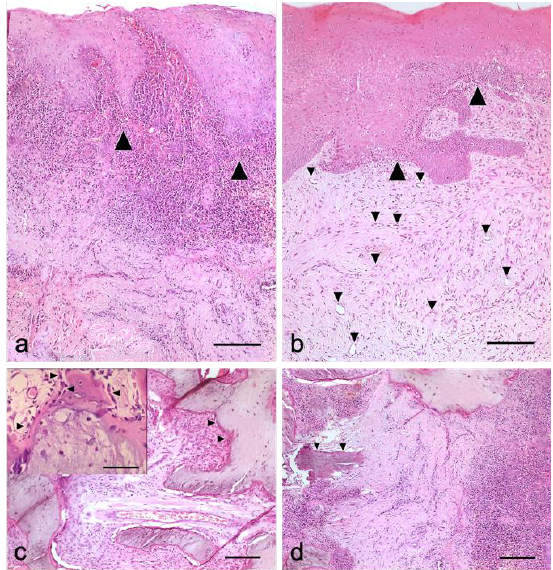
Figure 7. Histological photomicrograph of hematoxylin and eosin (H&E)-stained sections of bioptic samples from a post-extractive surgical wound, three weeks after the surgery: ( a ) untreated sample from control group shows an abundant infiltration of inflammatory cells in the epithelial layer (arrow heads), with an irregular epithelial layer, micro-hemorrhages, and extensive edema, indicating poor repair parameters; ( b ) surgical site treated with PRF reveals scant inflammatory cells with epithelial hyperplasia (big arrow heads) and new collagen synthesis with irregular orientation, which is associated with remarkable neo-angiogenesis (arrow heads); ( c ) biopsy sampled at the level of the periodontal bone from a surgical site treated with PRF evidences ontogenetic processes (arrow head), with some new osteoid-synthetizing basophilic osteoblasts with large activated nuclei (insert, arrow heads); ( d ) bone sampled from a surgical site in which no treatment was applied—a moderate persisting inflammatory response with some fragments of bone being resorbed by osteoclasts is indicated by the arrow head. H&E, scale bar = 400 µm (In insert, bar = 250 µm).